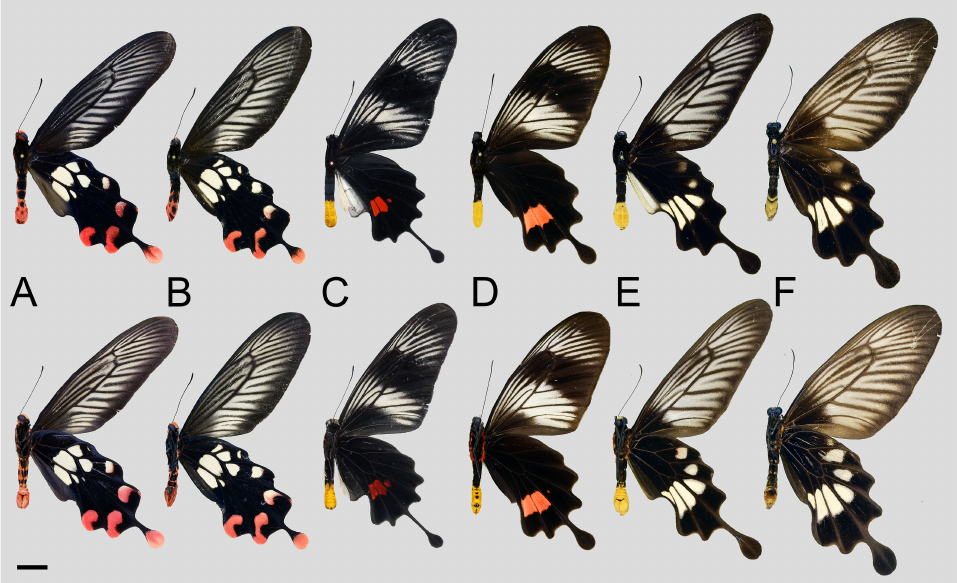
Figure 4. Morphological comparison of Losaria rhodifer (A: male row; scale bar = 10